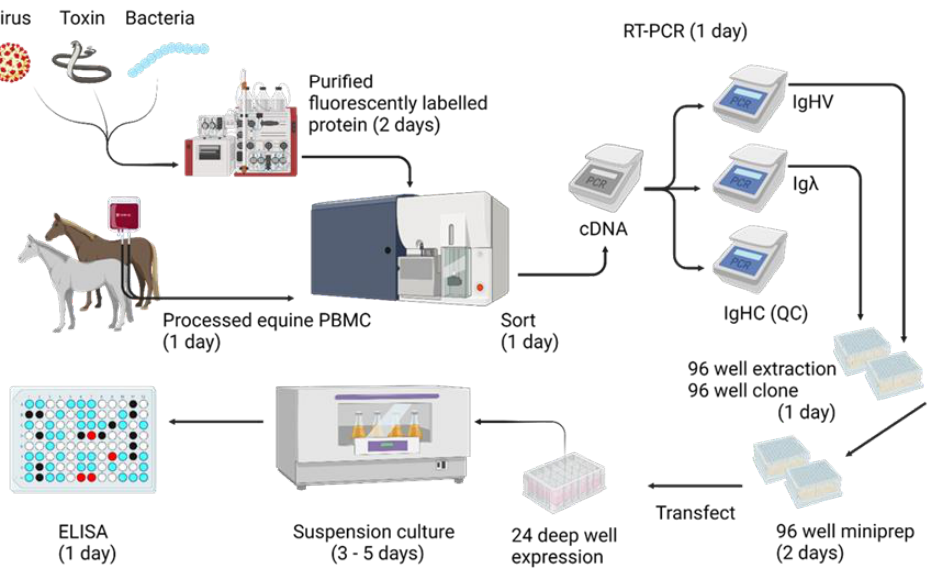
Figure 5. A high-throughput monoclonal antibody isolation pipeline for horses.